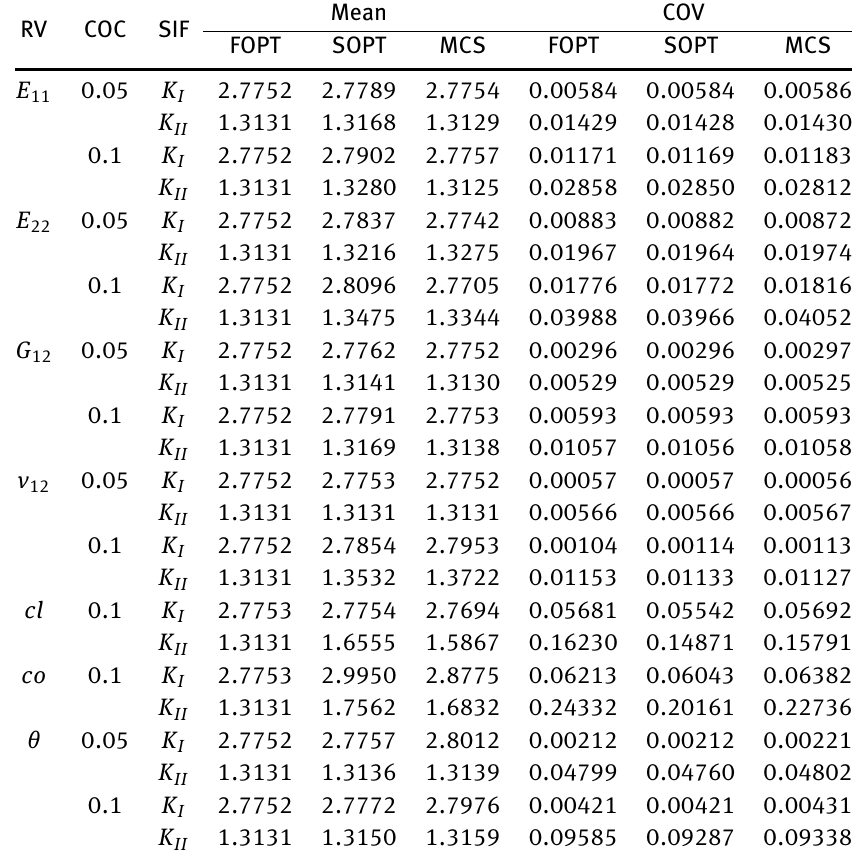
Table 6: Effect of individual random system variables on the normalized mean and COV of SIFs K I and K II of single edge V- notched compos- ite [0 ◦ /15 ◦ /15 ◦ /0 ◦ ] plate.